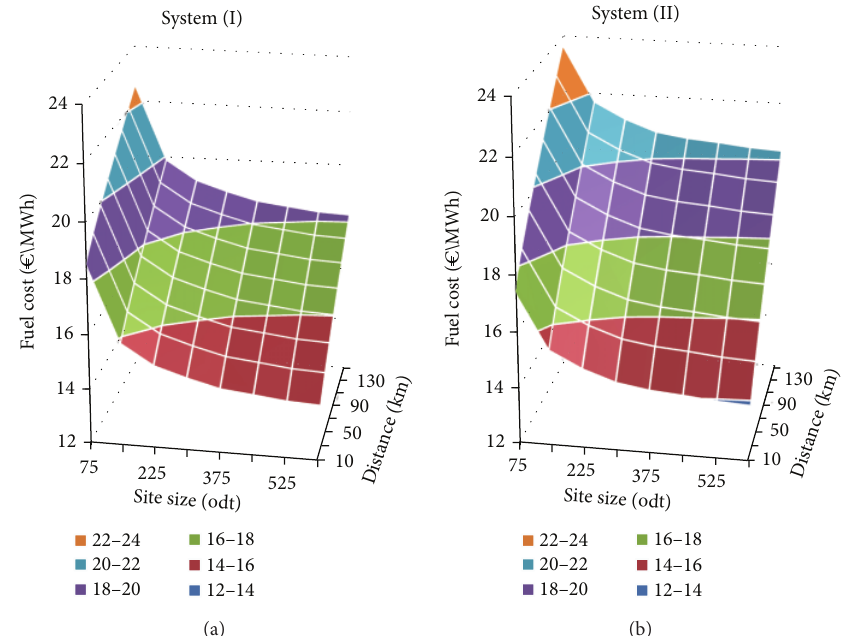
Figure 8: Response-surface diagram with varying stump transport distance (10–150 km) and stump harvesting site size (75–600 odt).